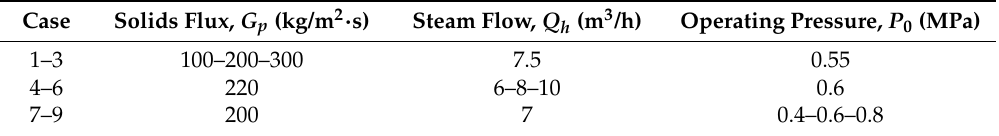
Table 2. Simulation cases and operating